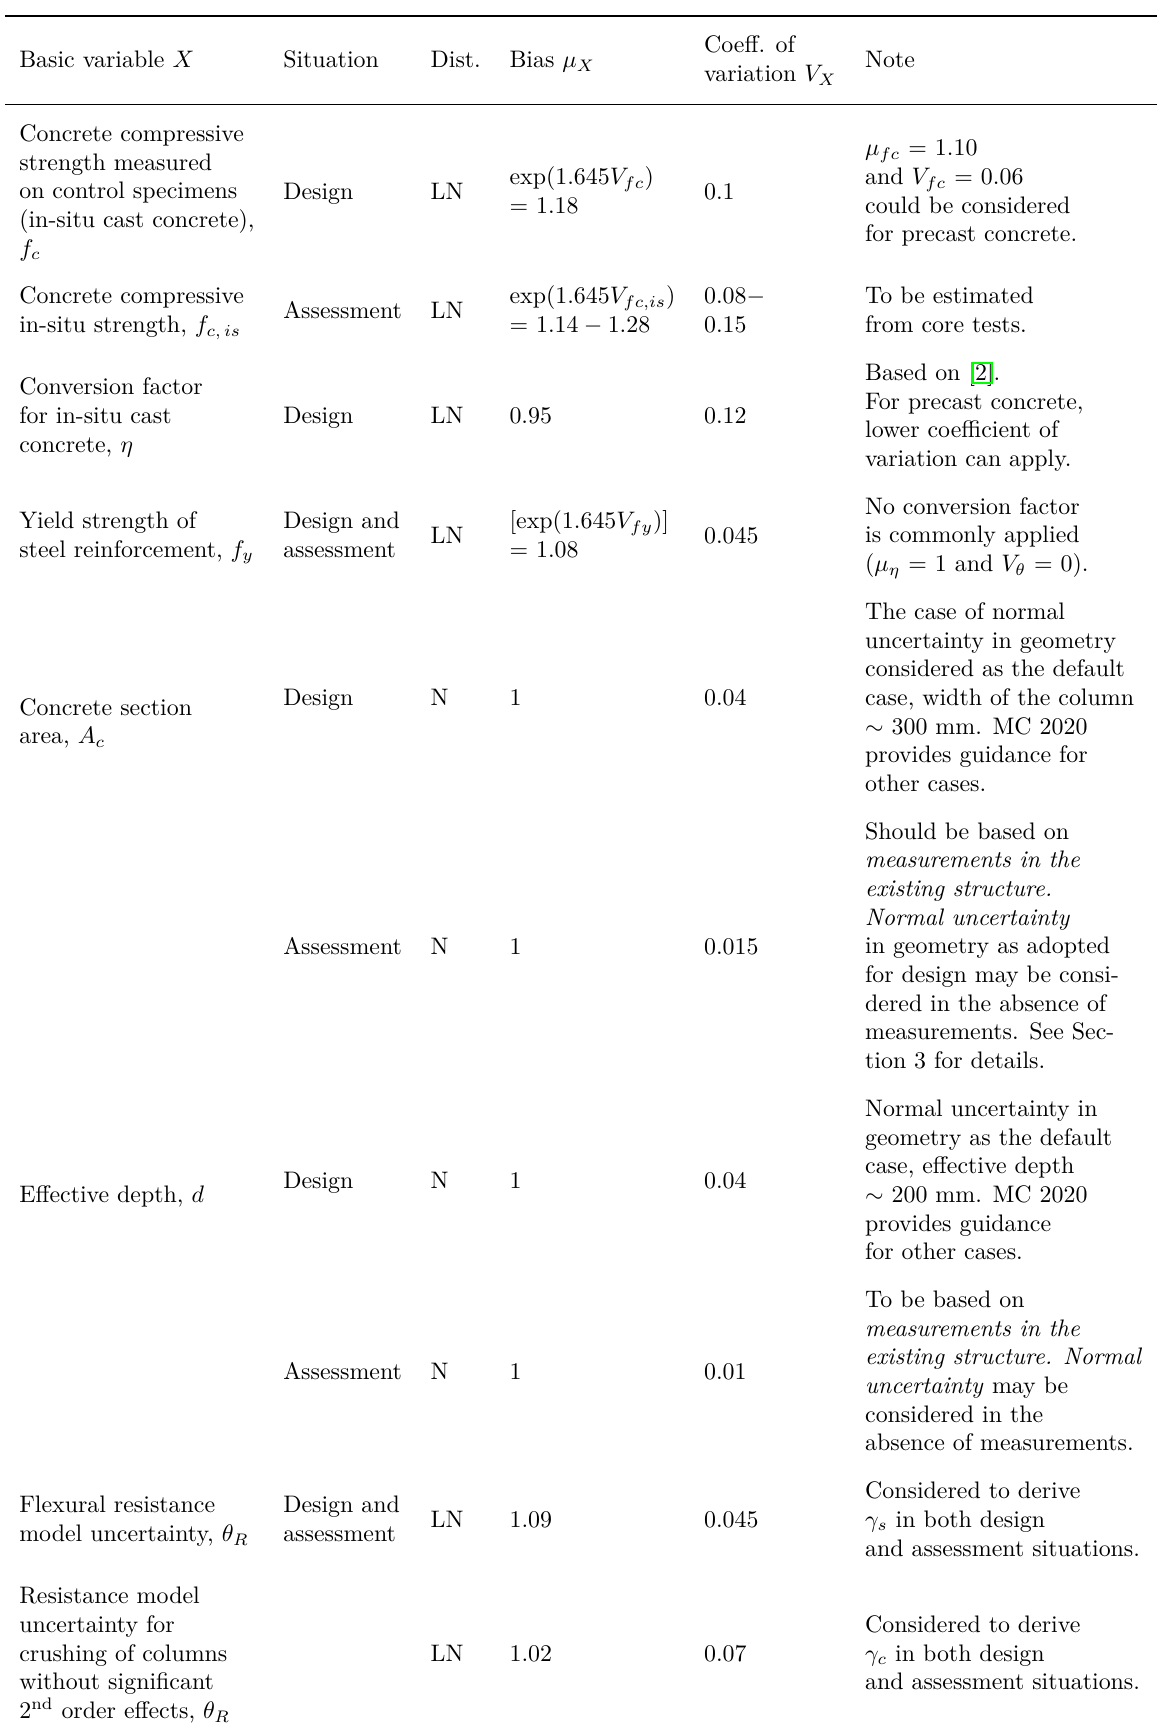
Table 1. Probabilistic models for resistance parameters considered in draft MC